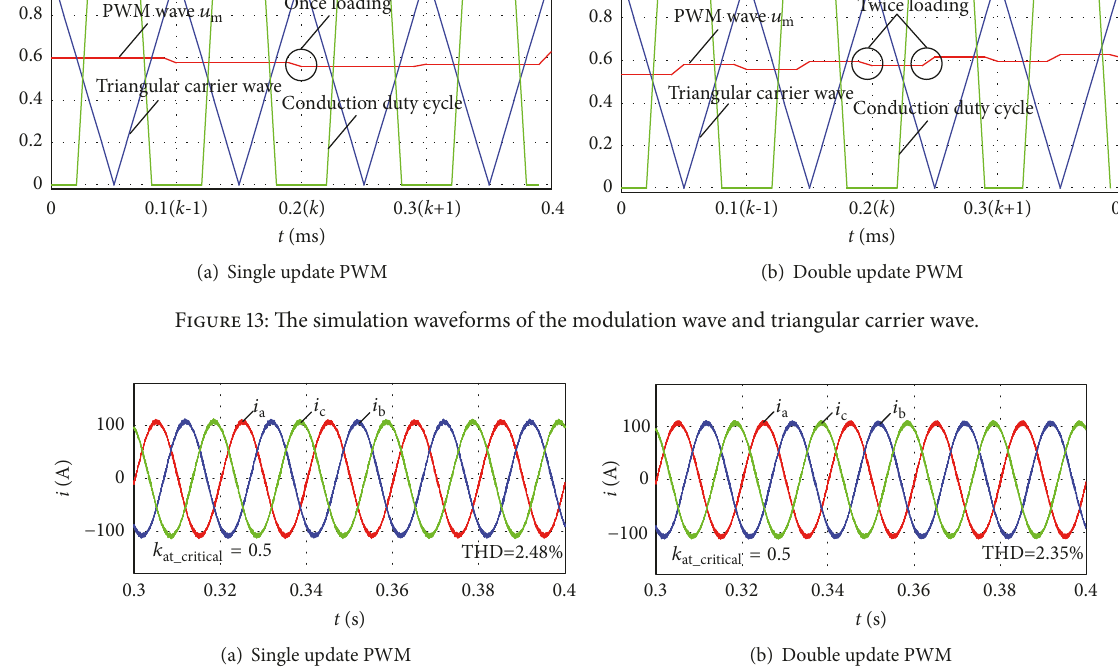
=0.5. at critical